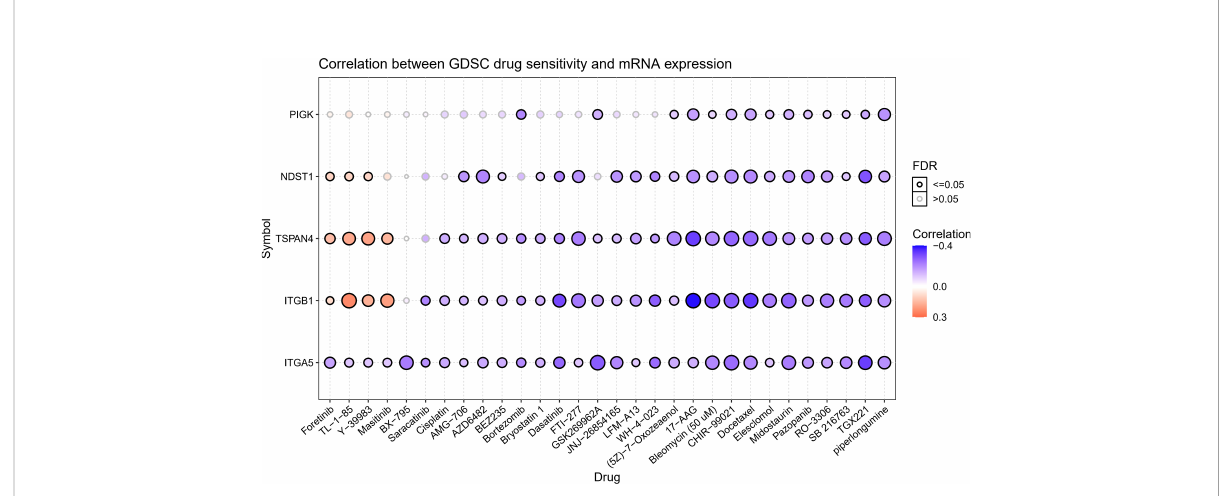
FIGURE 4 Expression of MRGs correlates with drug sensitivity. A positive correlation indicates that a highly expressed gene is drug-resistant and vice versa.